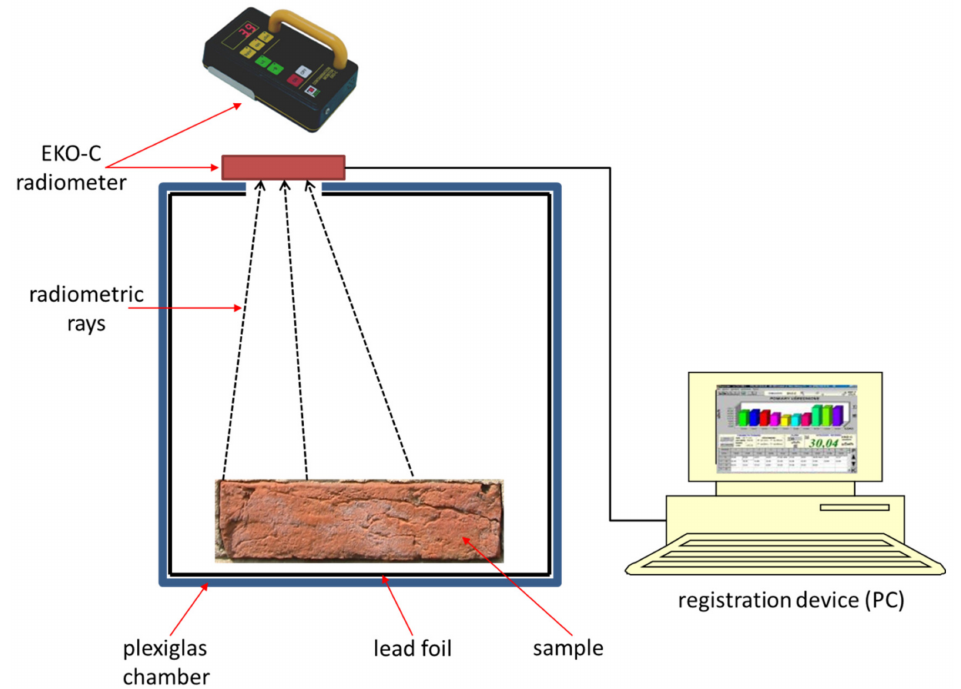
Figure 2. Scheme of the measuring